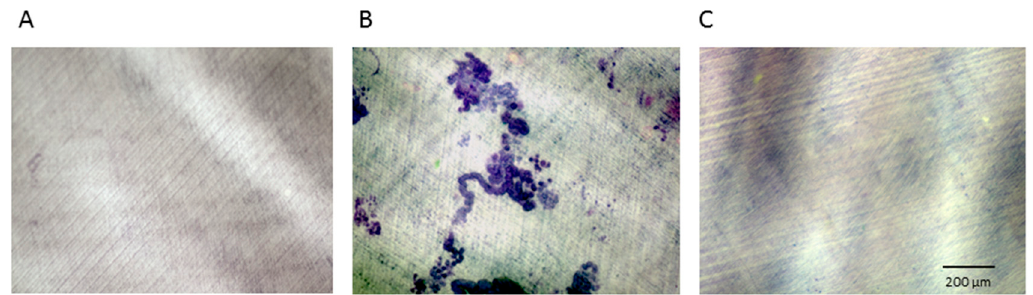
Figure 2. Resorptive activity of PBMC -M-CSF/RANKL ( A ), PBMC +M-CSF/RANKL ( B ), and PBMC +M-CSF/RANKL + DMAB ( C ) on dentine chips.